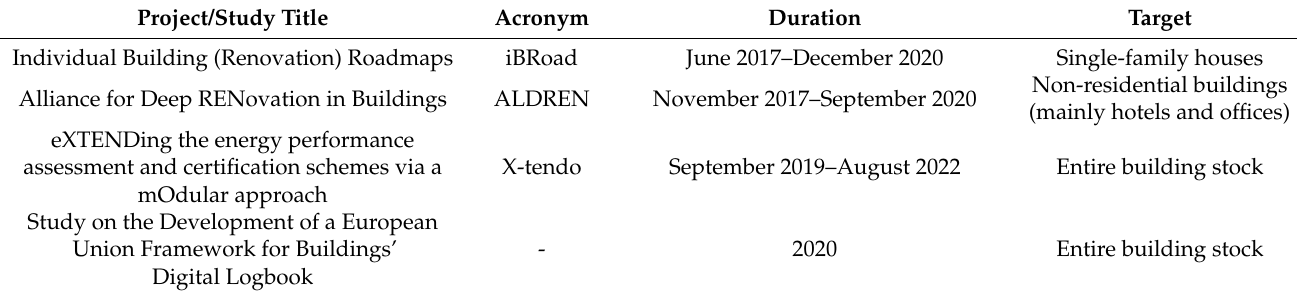
Table 2. Projects basic